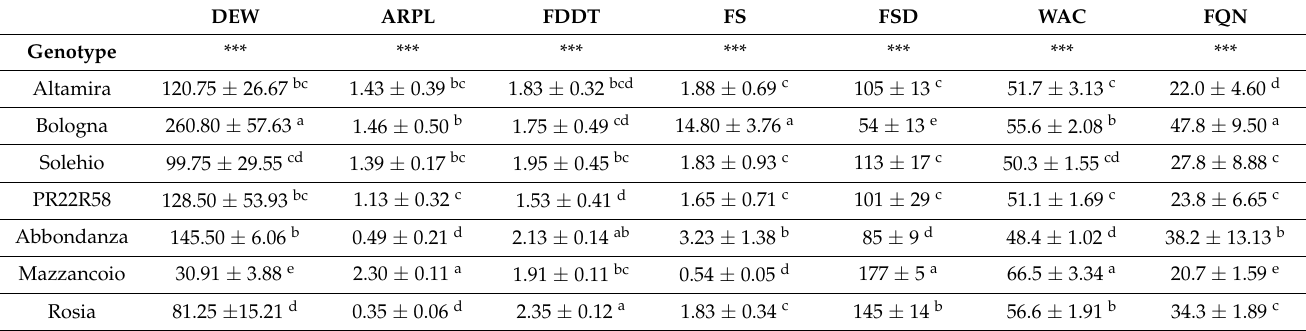
Table 4. Alveograph and farinograph